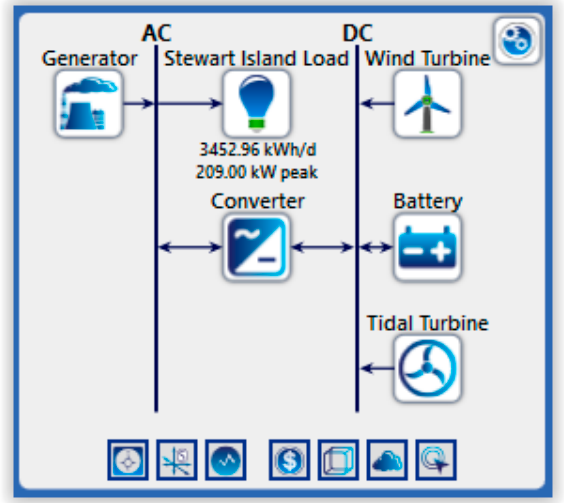
Figure 7. Schematic layout of DC microgrid.